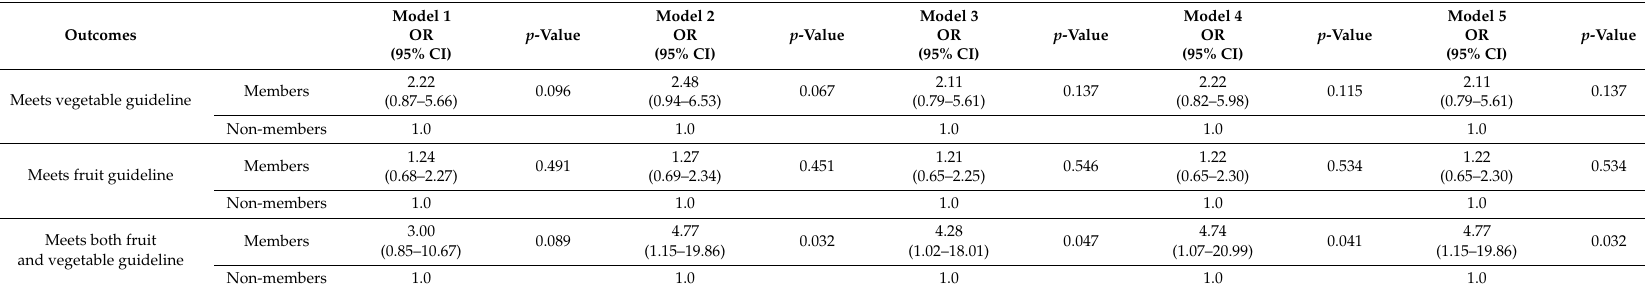
Model 2 Model 1 p -Value OR OR (95% CI)